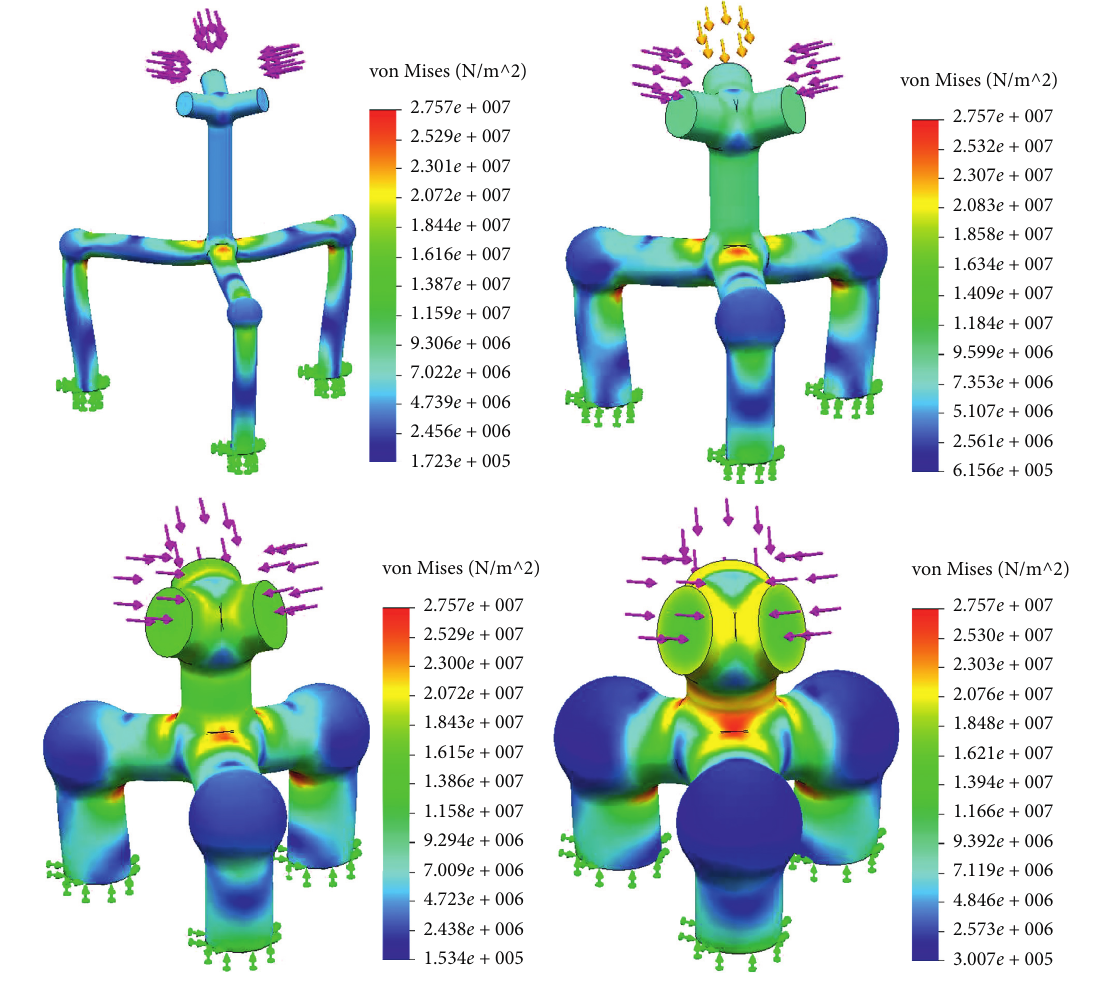
Figure 9: Simulation analysis of diamond lattice structure unit. Table 2: Comparison of simulation data of diamond lattice structure